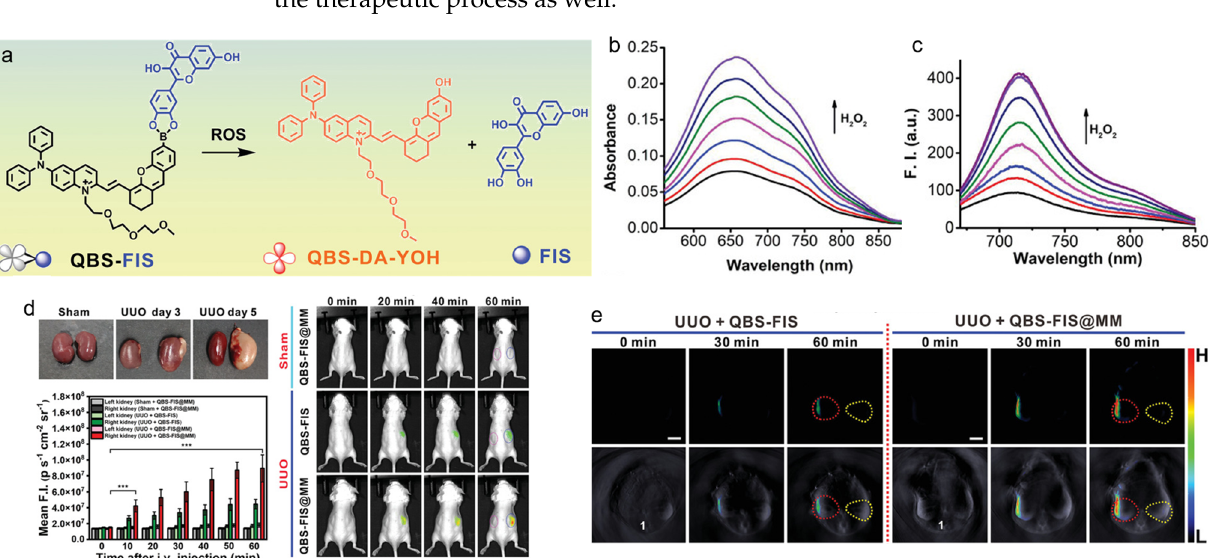
Figure 7. ( a ) The AIE probe for H 2 O 2 detection; ( b ) PL and ( c ) absorption spectra of BTPE-NO 2 with the treatment of different concentrations of H 2 O 2 ; ( d ) NIR-II fluorescence and ( e ) PA imaging of